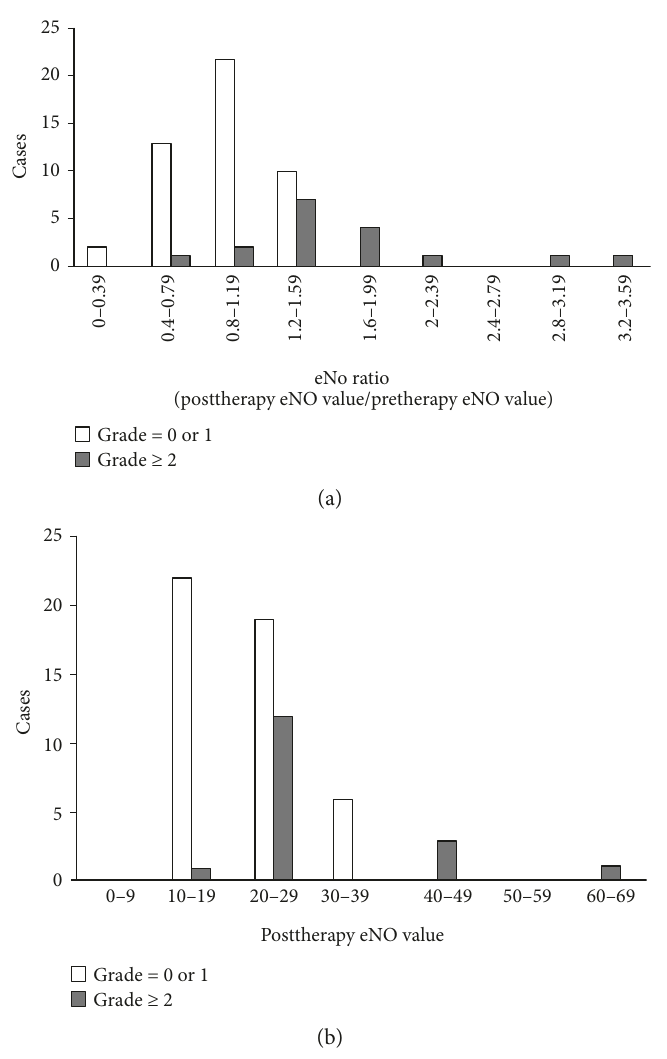
Figure 2: (a) eNO-changing ratios; (b) postradiotherapy eNO values. Orange: group SRP; blue: group